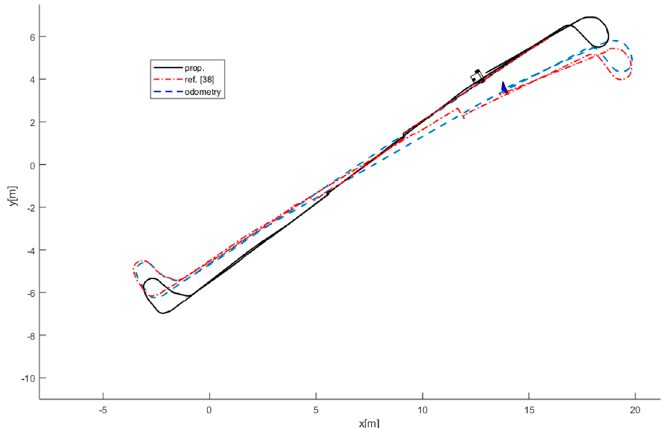
Figure 13. Comparison between the proposed method and described method in Figure 13. comparison between the proposed method and described method in [38].